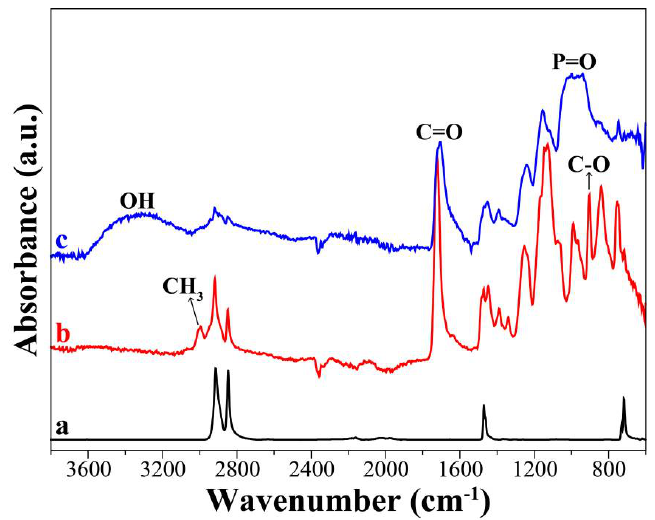
Figure 2. ATR-FTIR spectroscopy of ( a ) original UHMWPE, ( b ) UHMWPE-g-PGMA (DG = 540%), and ( c ) UHMWPE-PO 4 (D PO = 1.93 mmol∙g −1 ) fibers.